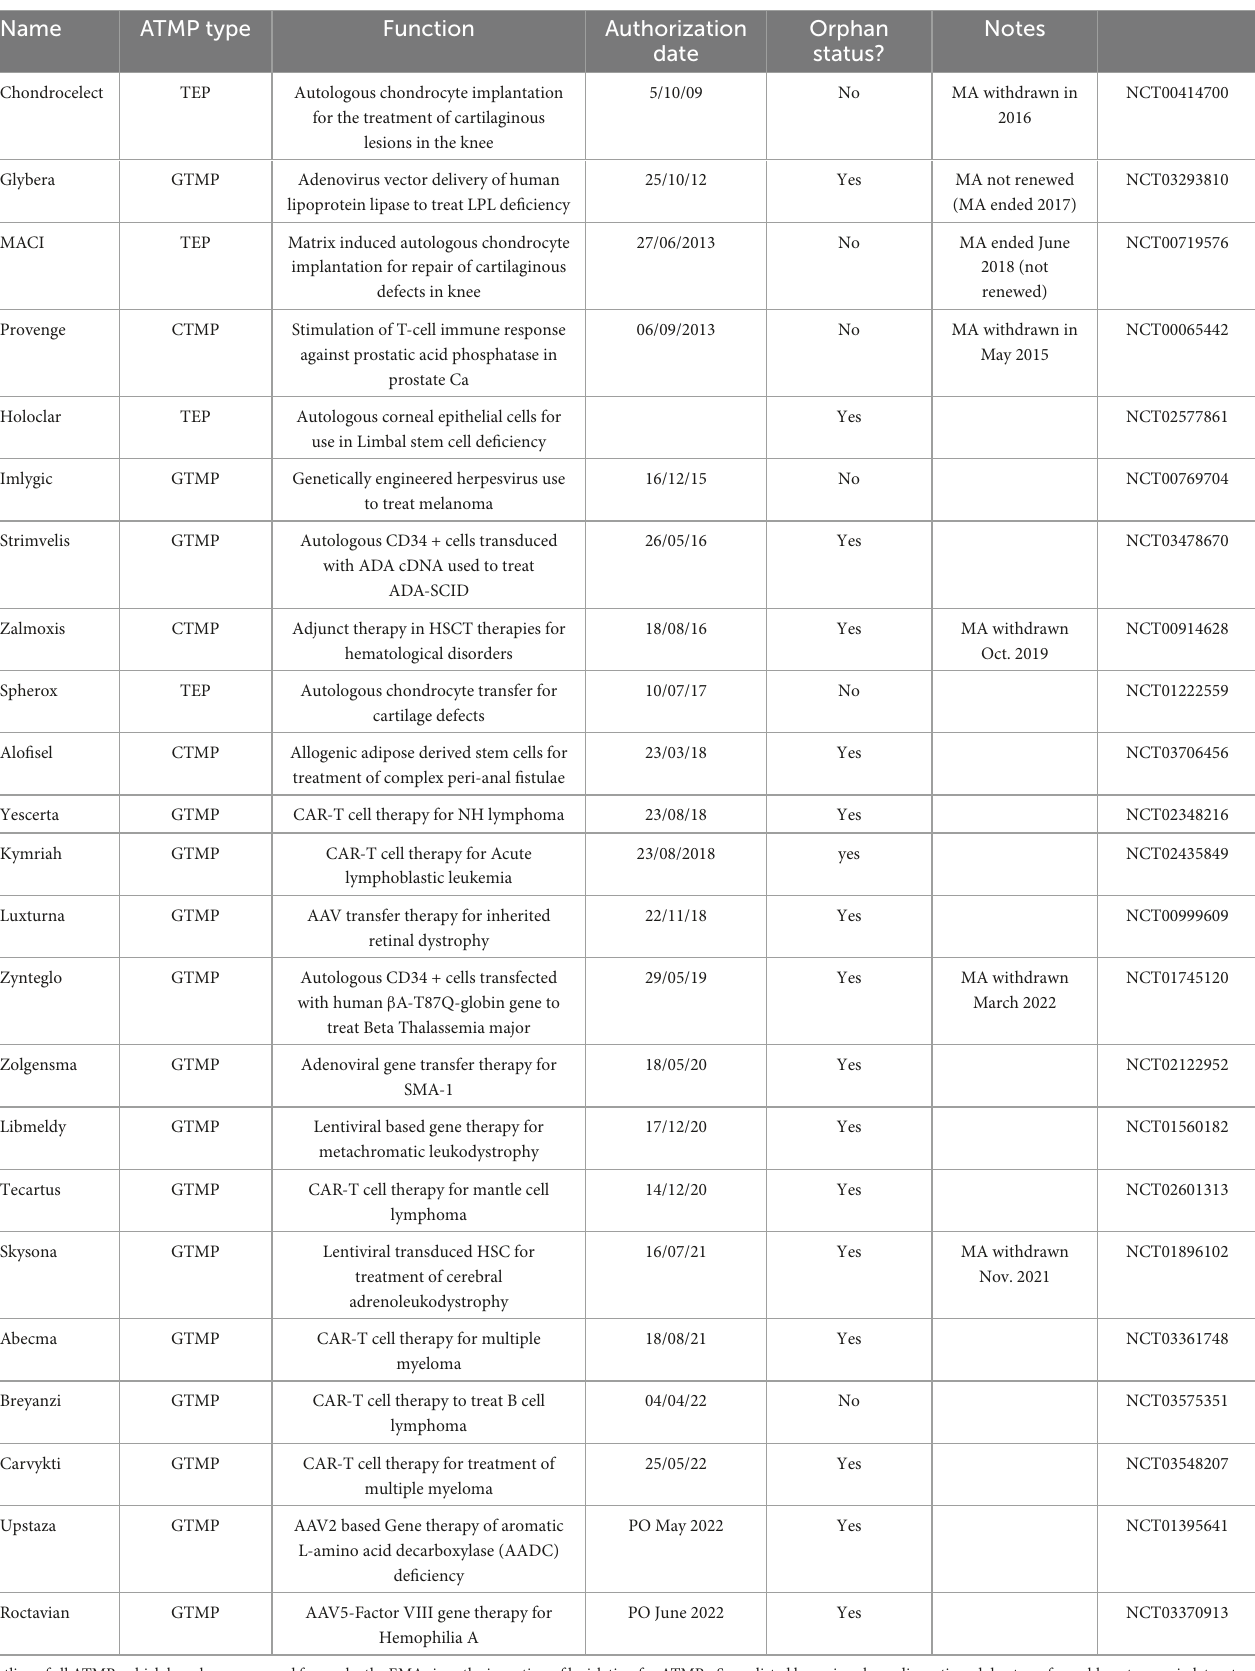
TABLE 1 Approved advanced therapy medicinal products (ATMPs) in